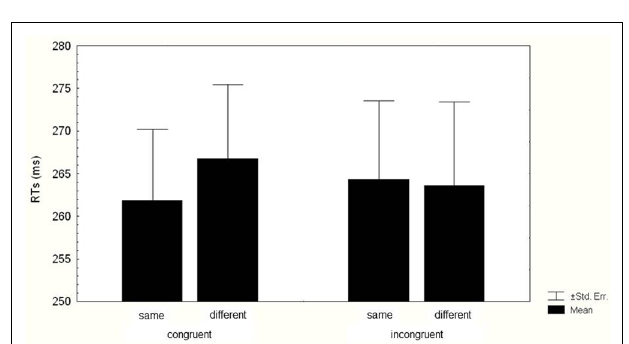
FIGURE 2 | The two objects presented in the videos. On the left, the object grasped by the experimenter in the original video (flat–flat video). On the right, the object artificially introduced via software as Cue (sharp–flat and sharp-catch videos), as Target (flat–sharp video), and as Cue and Target (sharp–sharp video).